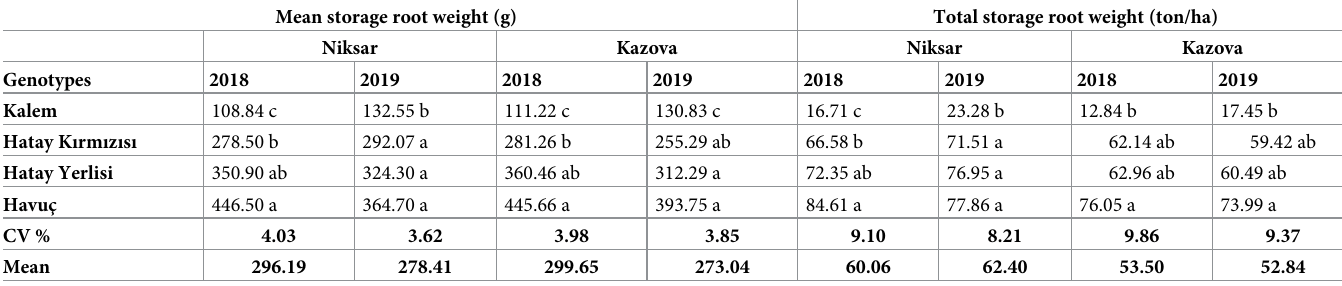
Means with different letters in a column are significantly different from each other at p <